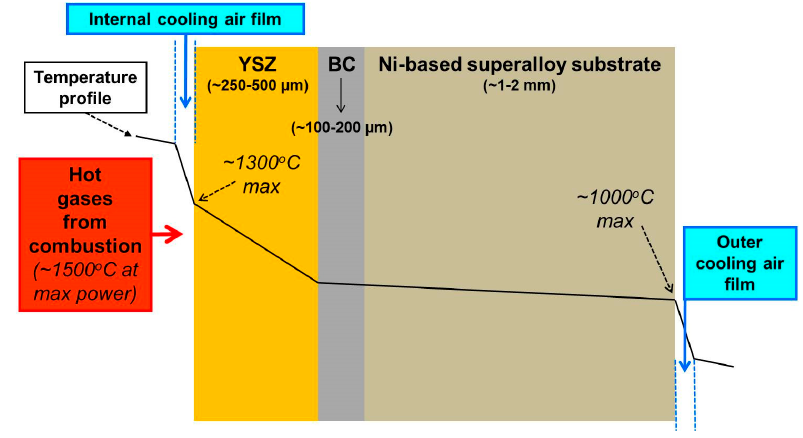
Figure 4. Schematic of the TBC/component in thermal gradient and air cooling.